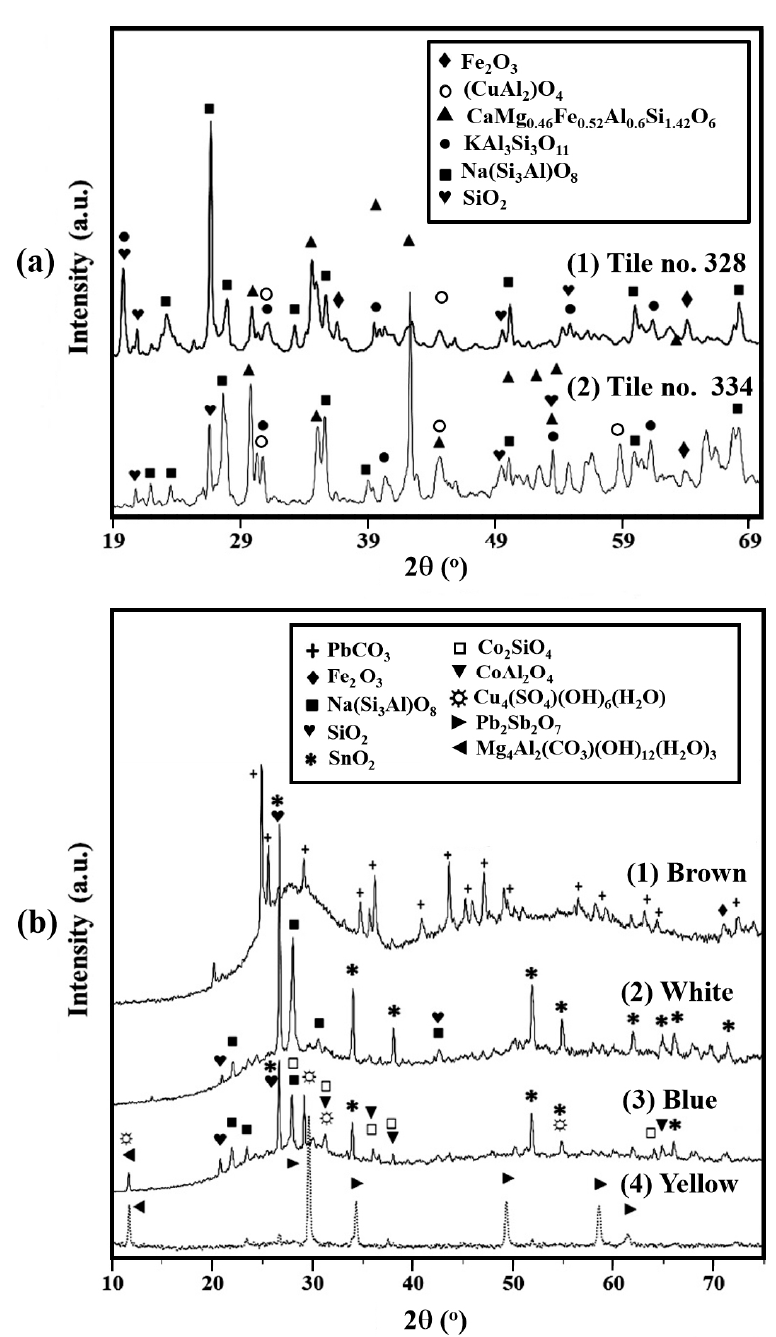
Figure 5. XRD analysis results: ( a ) clay body of tiles 328 (Type B, graph 1) and 334 (Type A, graph 2); and ( b ) the white (graph 2), yellow (graph 4), and blue (graph 3) pigments of Tiles 334 and 340 (Type A), and the brown pigment of tile no. 328 (Type B, graph 1).